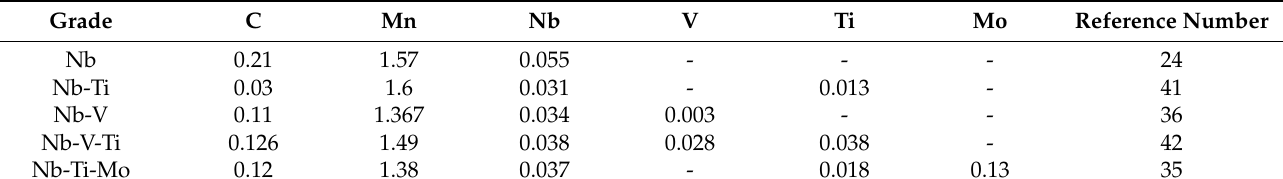
Table 3. Chemical composition (wt.%) of carbon steels from reference data.